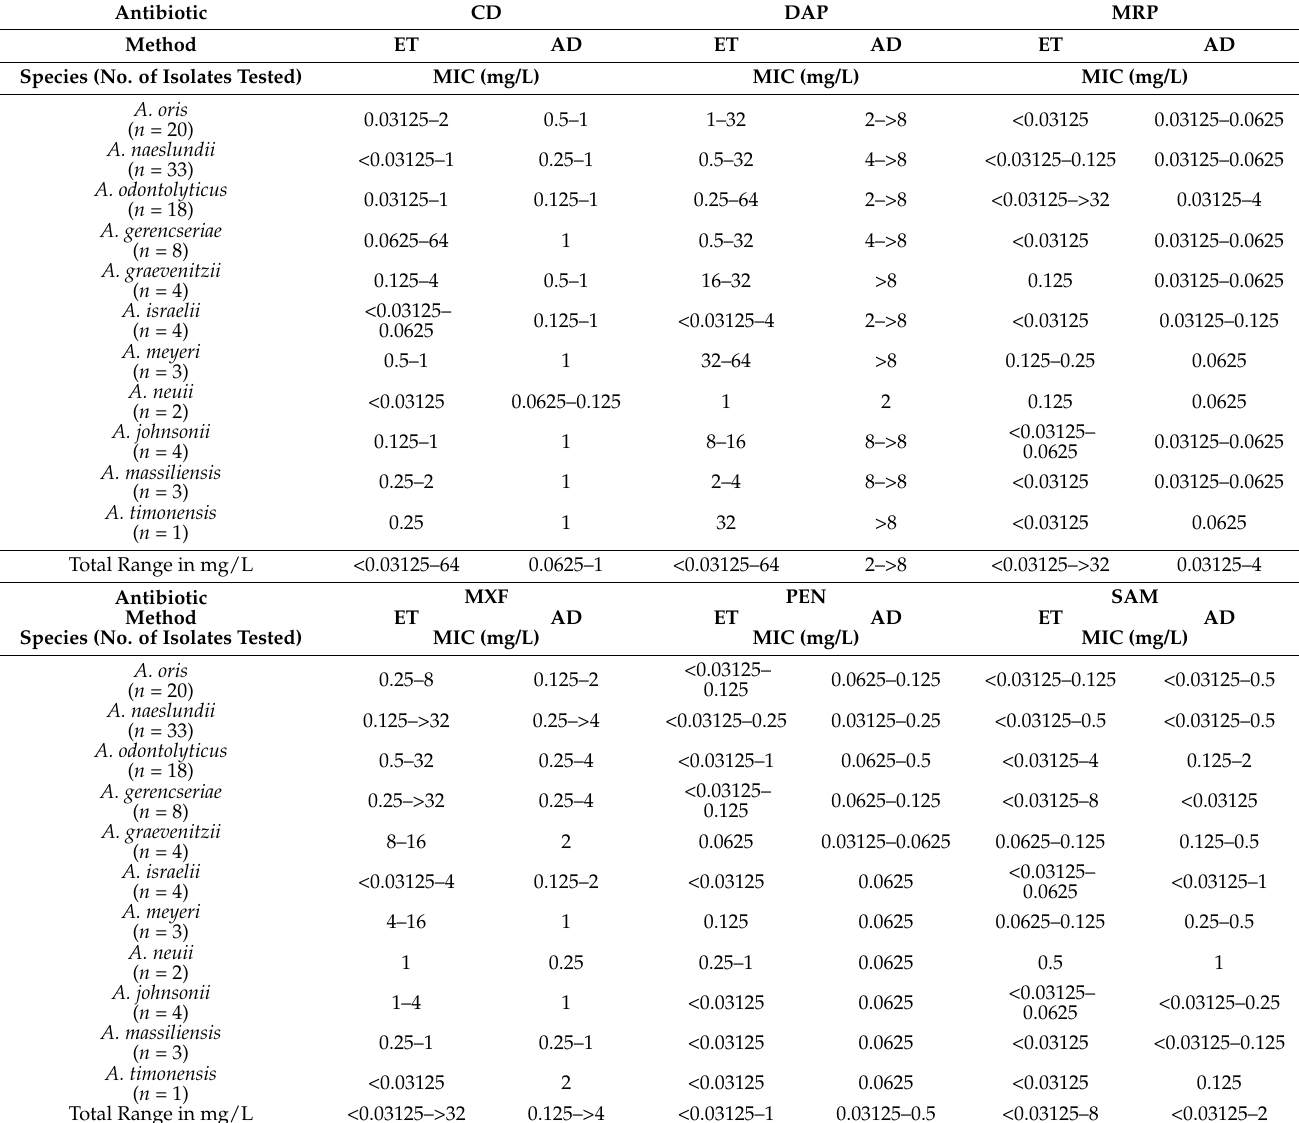
Table 3. MIC range of Actinomyces spp. tested against selected antimicrobial agents comparing the agar dilution and E-Test